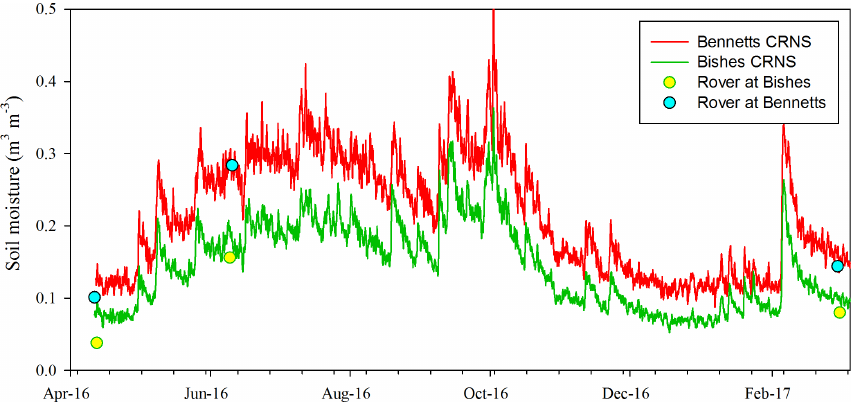
Figure 8. Comparison of Bennetts and Bishes CRNS soil moisture estimates and corresponding intensive rover survey estimates for the CRNS locations for the three survey dates. Rover survey estimate is from 1km resolution pixel corresponding to each CRNS location.